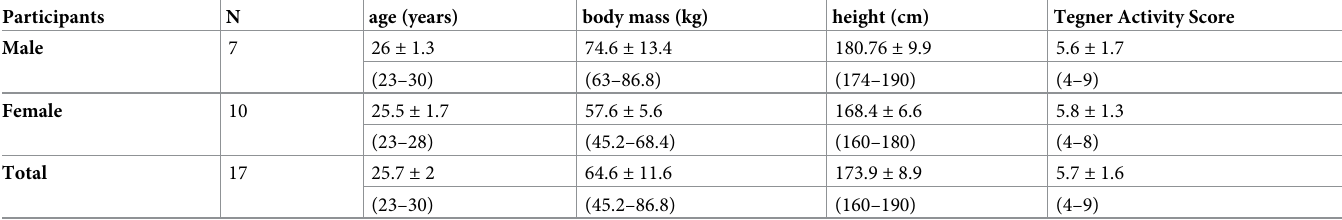
Table 1. Characteristics of the evaluated study